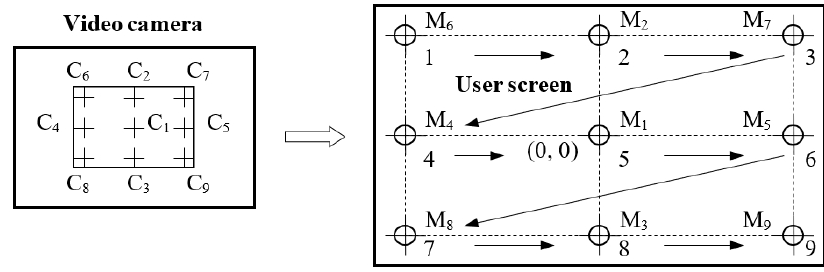
Figure 2. Mapping between eye pupil image and user screen cursor [50] (© 2015 IEEE).